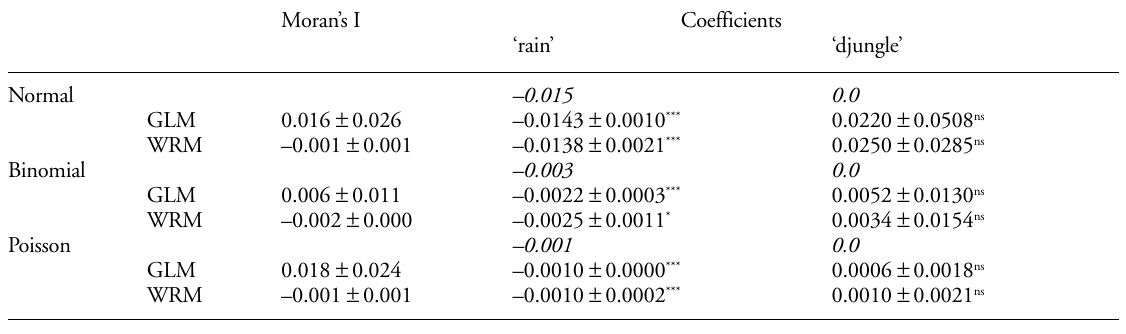
Table 1. Model quality: Spatial autocorrelation in the model residuals (given as global Moran’s I) and mean estimates for the coefficients ‘rain’ and ‘djungle’ ( ± 1 SE across the 10 simulations). True coefficient values are given in the first row for each distribution in italics. *** , * and ns refer to median significance levels of p < 0.001, 0.01 < p < 0.05 and p > 0.1, respectively, across the 10 realisations. GLM: Generalized linear model, WRM: Wavelet-revised model.